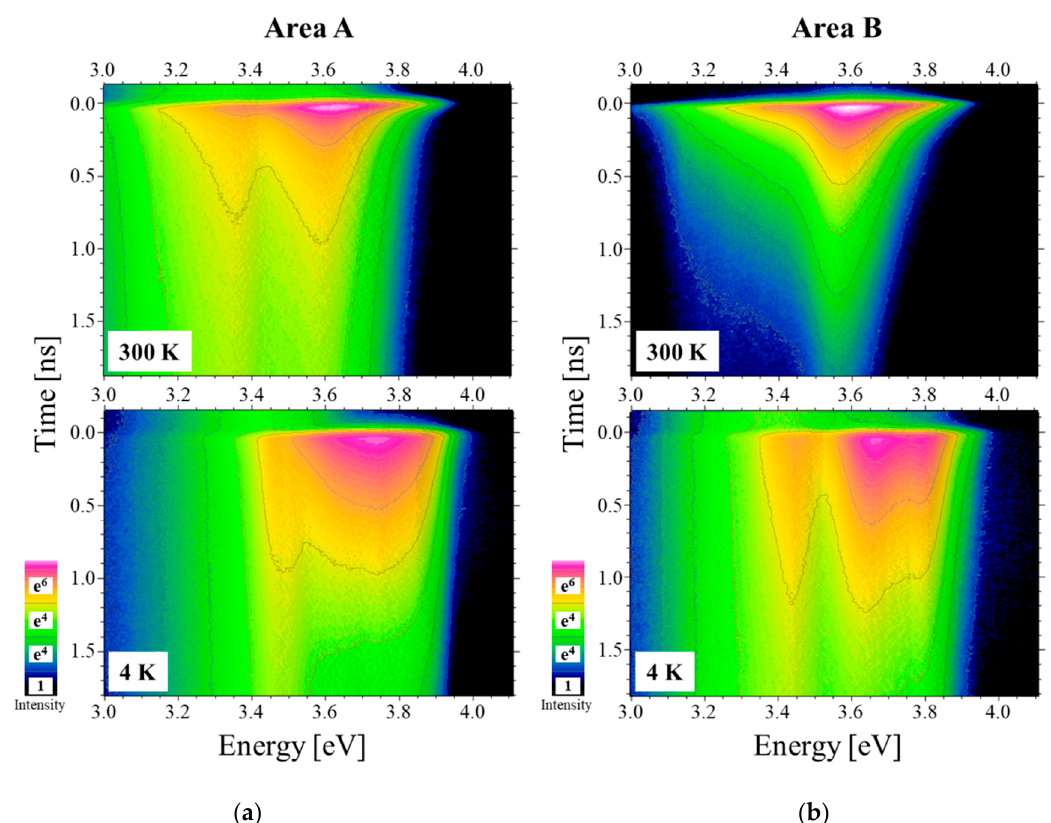
Figure 5. Time-resolved photoluminescence spectra in area A ( a ) and B ( b ) at T = 300 K (upper panels) and T = 4 K (bottom panels). The GaN emission can be seen in the 3.3–3.5 eV range, and that of AlGaN can be observed in the 3.6–3.8 eV range. The lifetimes at a low temperature are visibly longer. It can be noticed that the AlGaN emission decays faster than the GaN emission. In area A, GaN PL has a longer lifetime.